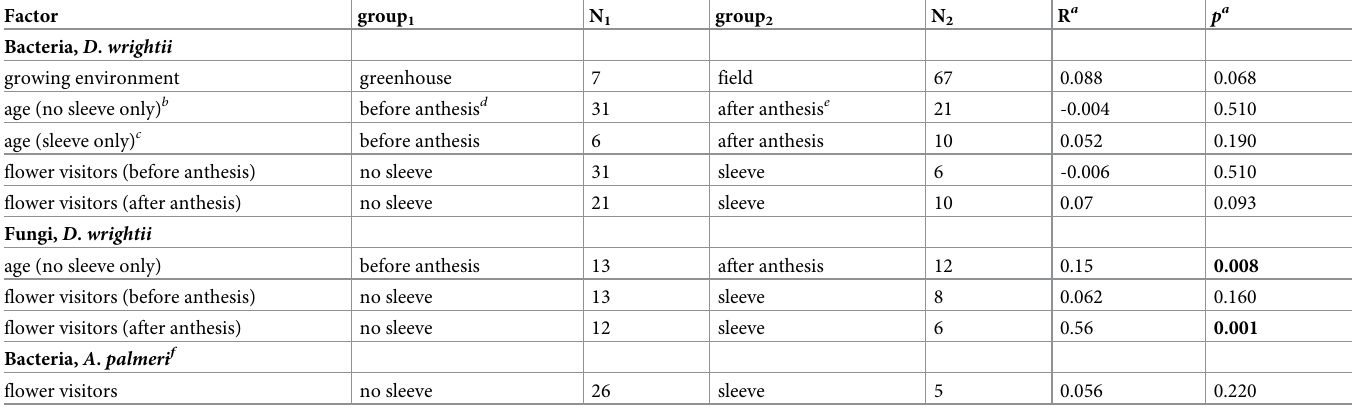
Table 1. Effects of growing environment, age and flower visitors on nectar microbe community composition in Datura wrightii and Agave palmeri in southeastern